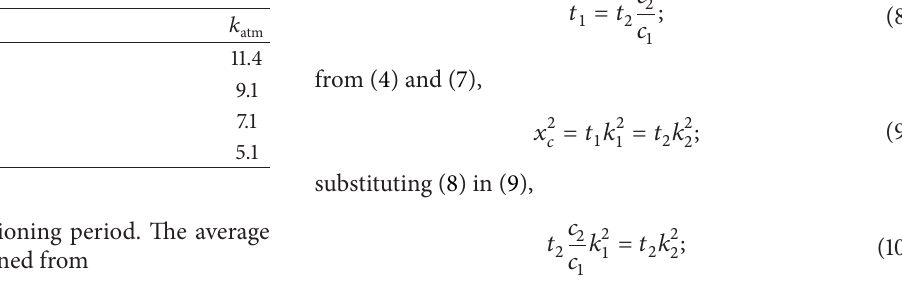
Table 5: Carbonation coefficients from accelerated and natural exposure (mm/y 1/2